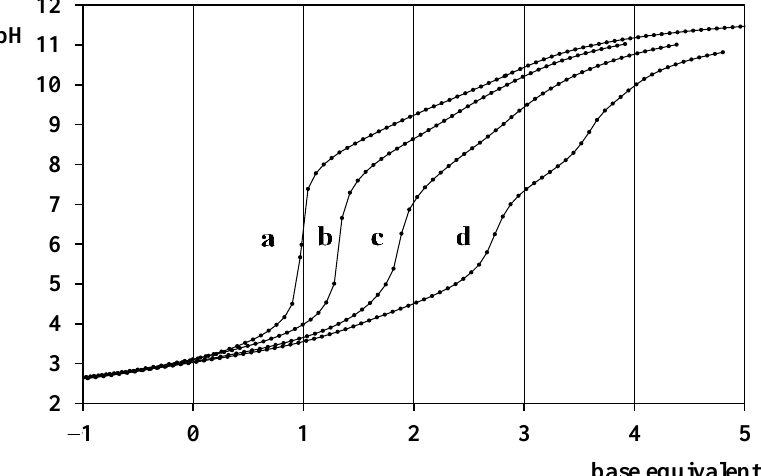
Figure 4. Representative titration curves of the H + –L3 ( a ) system and the [( η 5 -Cp*)Rh] 2+ –L3 system at 1:2 ( b ), 1:1 ( c ) and 2:1 ( d ) metal-ion-to-ligand-ratio s (c L3 = 2.45 mM). Negative base equivalent refers to an excess of acid in the sample.